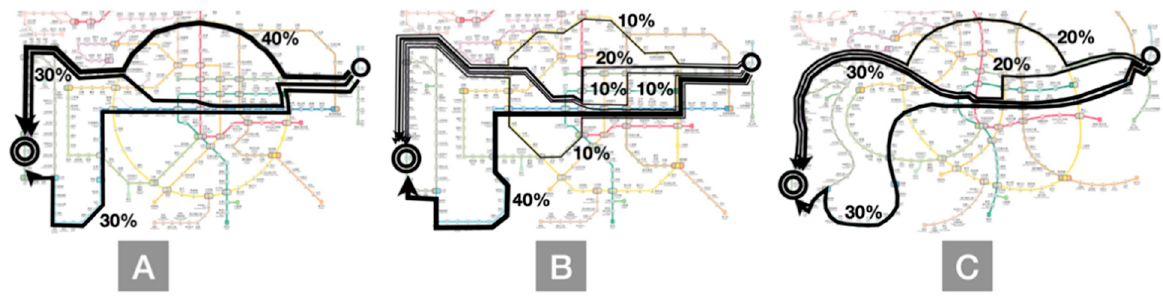
Figure 13. Proposal ( A – C ) showed different representations might affect the route choice even with the same routes. In Task Q4, the terminal station was on the yellow Circular line, and no other route was connected to this station. In Proposal A, the Circular line was represented in a perfect circle, which differed considerably from the straight lines of other routes. Overall, 90% of the participants selected the Circular line as their main route; 60% of the participants opted for upward routes with fewer detours, whereas 30% of the participants selected routes